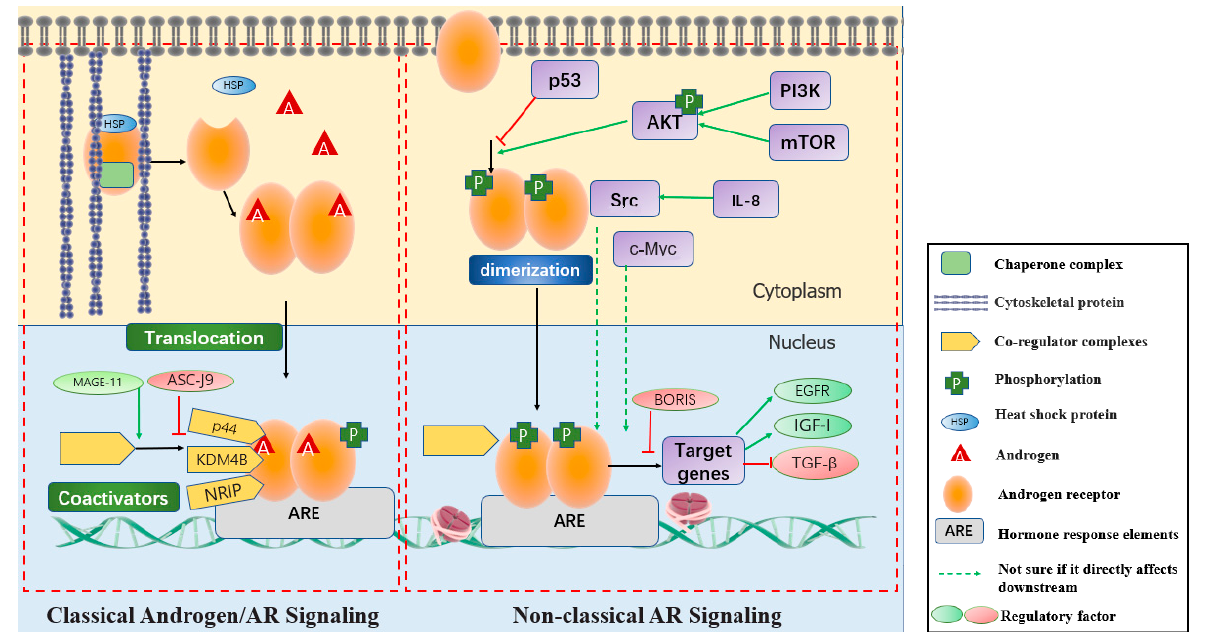
Figure 2. Schematic of classical and non-classical androgen(A)/androgen receptor (AR) signaling. The red box on the left: AR is immobilized in the cytoplasm by actin. AR dissociates from heat shock protein (HSP) and binds to A, forming A dimer and translocation into the nucleus. Co-regulators (KDM4B, NRIP, etc.) regulate transcriptional activity of AR at androgen response elements (ARE) and AR mediates transcription of downstream target genes. MAGE-11: Melanoma antigen gene protein 11; ASC-J9: Dimethylcurcumin; p44: A 44 kDa AR-interacting protein; KDM4B: The histone demethylase 4B; NRIP: Nuclear receptor interacting protein. The red box on the right: AR is activated in a non-ligand-dependent manner under the interaction of multiple regulatory factors (AKT, Src, etc.), mediating transcription of downstream target genes. p53: A tumor suppressor gene; AKT: Serine/threonine kinases of the AGC family; FoxO: Forkhead box O; Src: Tyrosine protein kinase; PI3K: Phosphatidylinositide 3-kinases; mTOR: Mammalian target of rapamycin; IL-8: Interleukin-8; c-Myc: A transcription factor; BORIS: Brother of the regulator of imprinted sites; EGFR: Epidermal growth factor receptor; IGF-I: Insulin growth factor I; TGF- β : transforming growth factor- β .